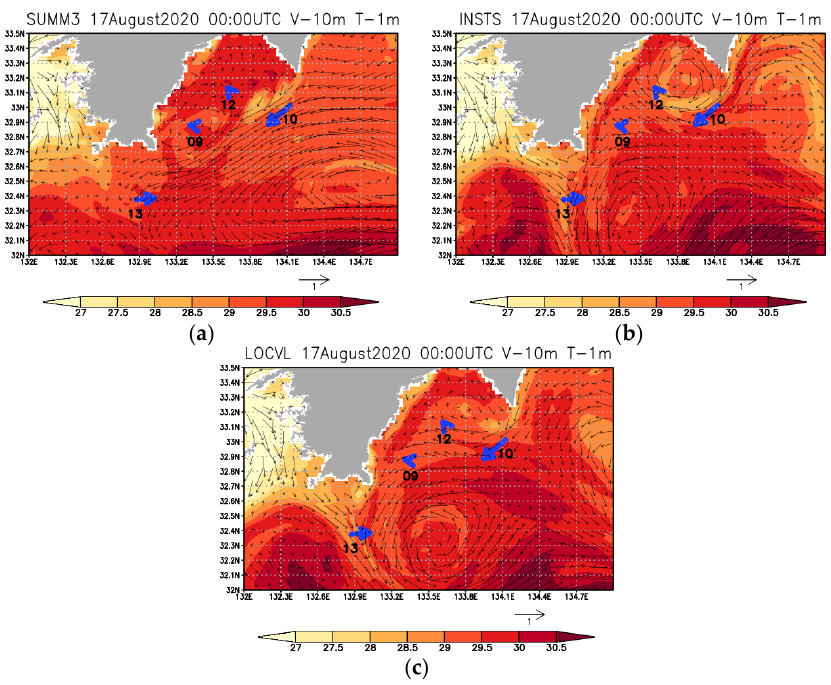
Figure 15. Same as Figure 8, except for three cases, ( a ) SUMM3, ( b ) INSTS, and ( c ) LOCVL.